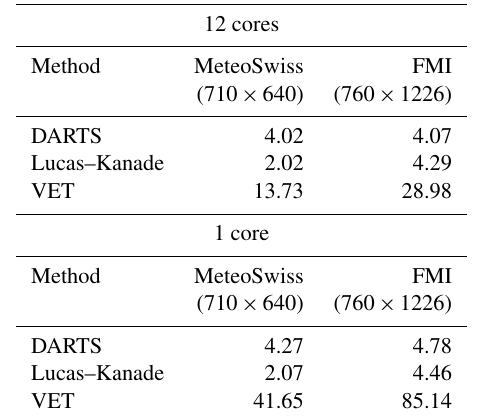
Table 6. Average computation times of different optical flow meth- ods in the MeteoSwiss and FMI domains (seconds). Domain sizes are given in